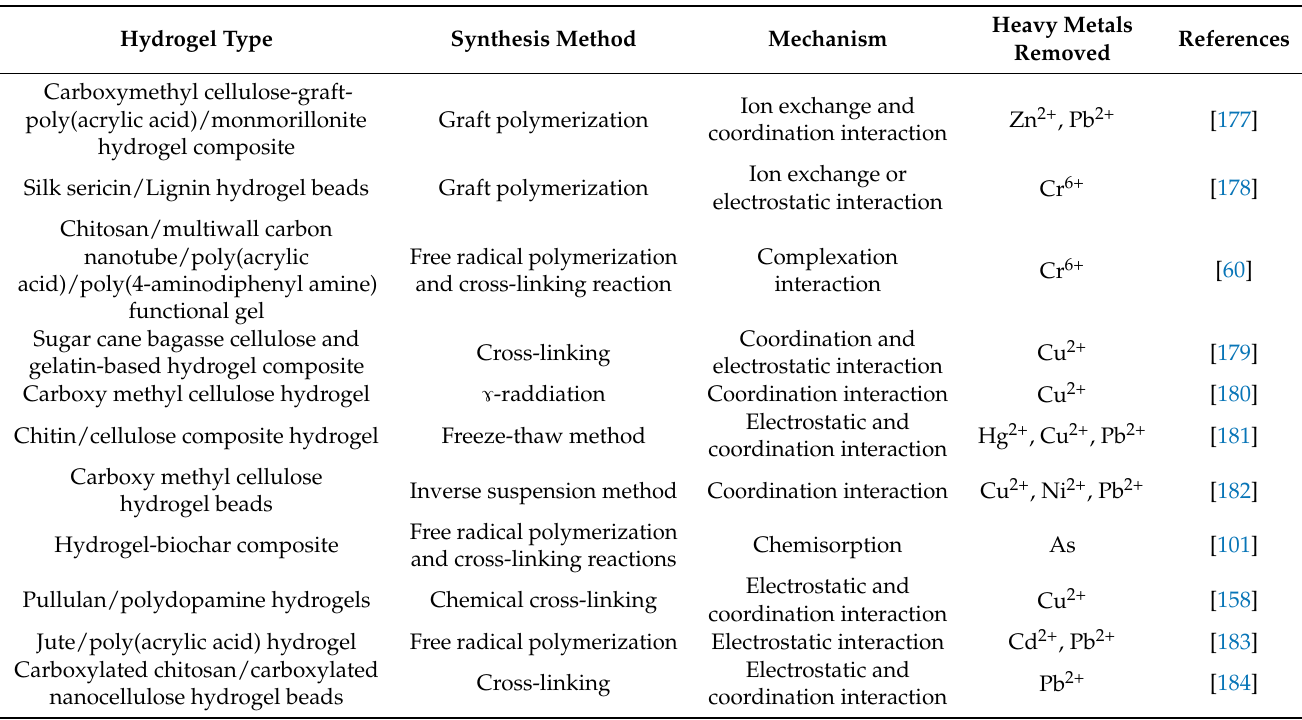
Table 6. Proposed synthesis and removal mechanism of various hydrogel-based